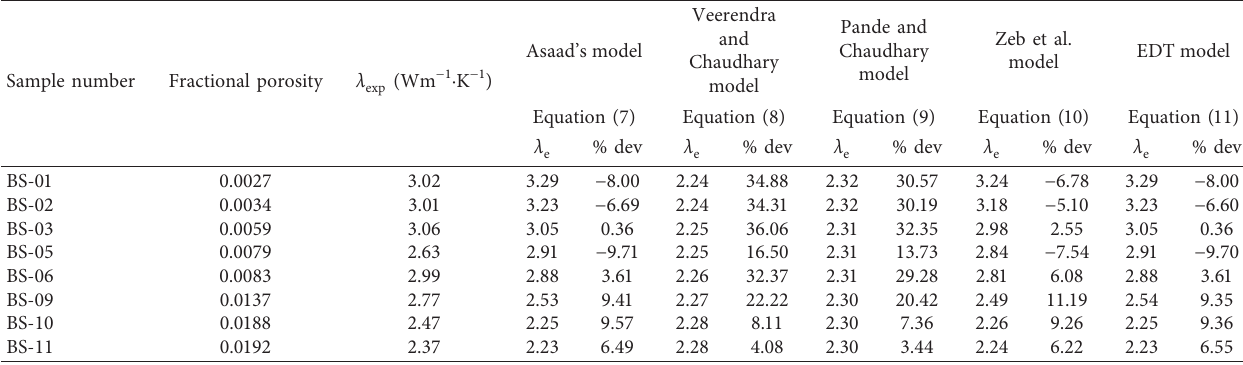
Figure 4: Comparison of experimental and empirical model thermal conductivities of the basalt samples as the function of fractional porosity. Table 5: A comparison of the measured experimental thermal conductivity and the effective thermal conductivity calculated according to different empirical models for basalt